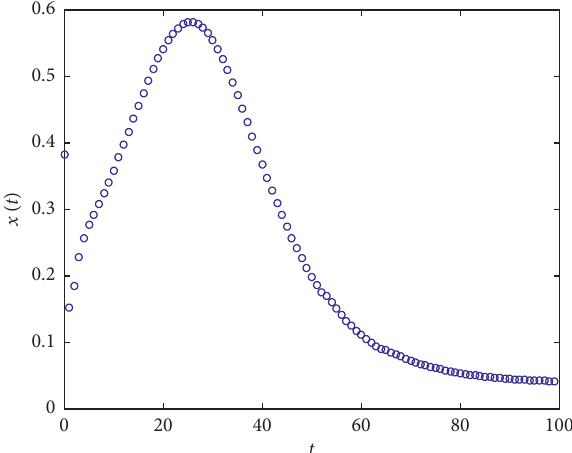
Figure 7: Evolution of average collective opinions